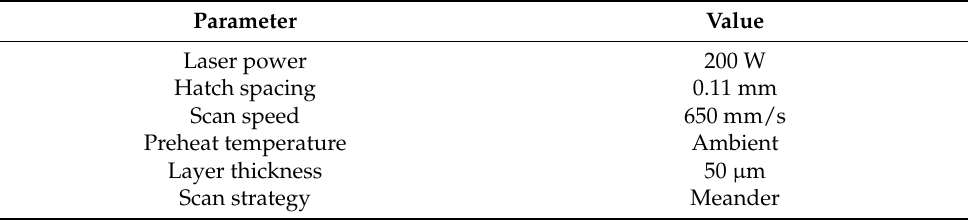
Table 4. Fabrication